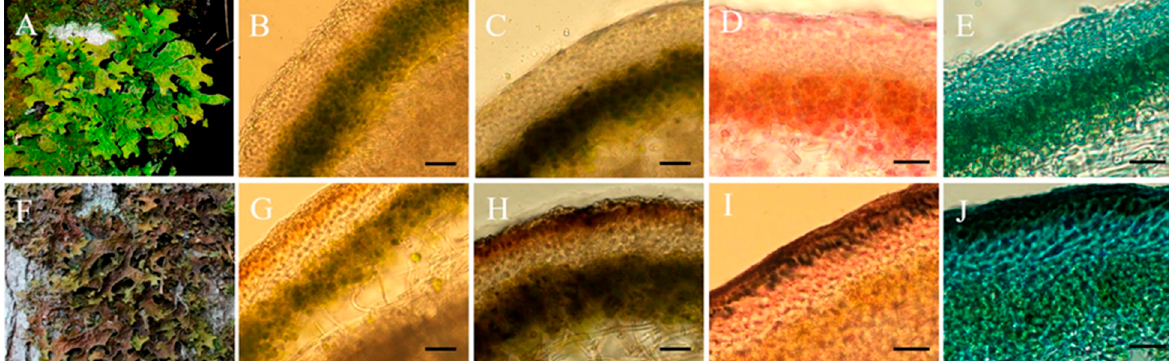
Figure 1. Non-melanized ( A – E ) and melanized ( F – J ) Lobaria pulmonaria thalli. Whole thalli ( A , F ). Cross sections of thalli: unstained ( B , G ), DOPA reaction ( C , H ), Rejniak staining ( D , I ), Lillie staining ( E , J ). Darkly stained melanins are clearly visible in the upper cortex of melanized thalli. Bar = 25 μ